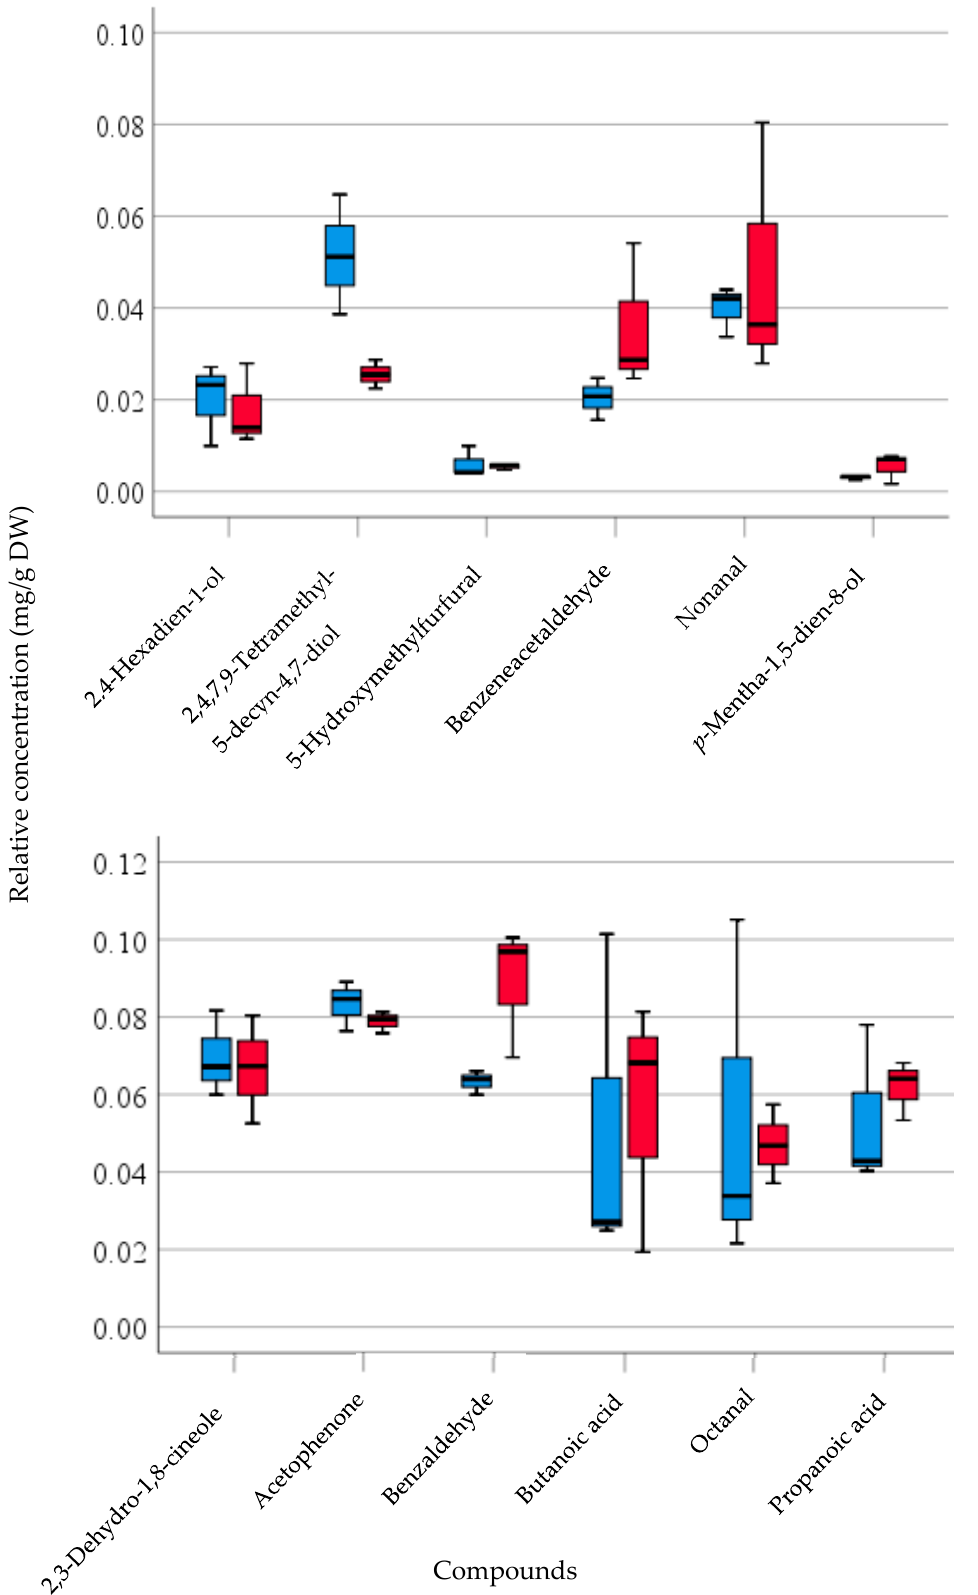
Figure 1. Comparison of relative concentration (mg/g DW) with respect to the internal standard of selected volatile compounds between fresh and freeze-dried pulp of tamarillo analyzed by TD–GC–MS. Data are presented showing median and quartiles in box-plot, and a range of each compound shown in whisker ( n = 3). ( Fresh, Freeze-dried sample).